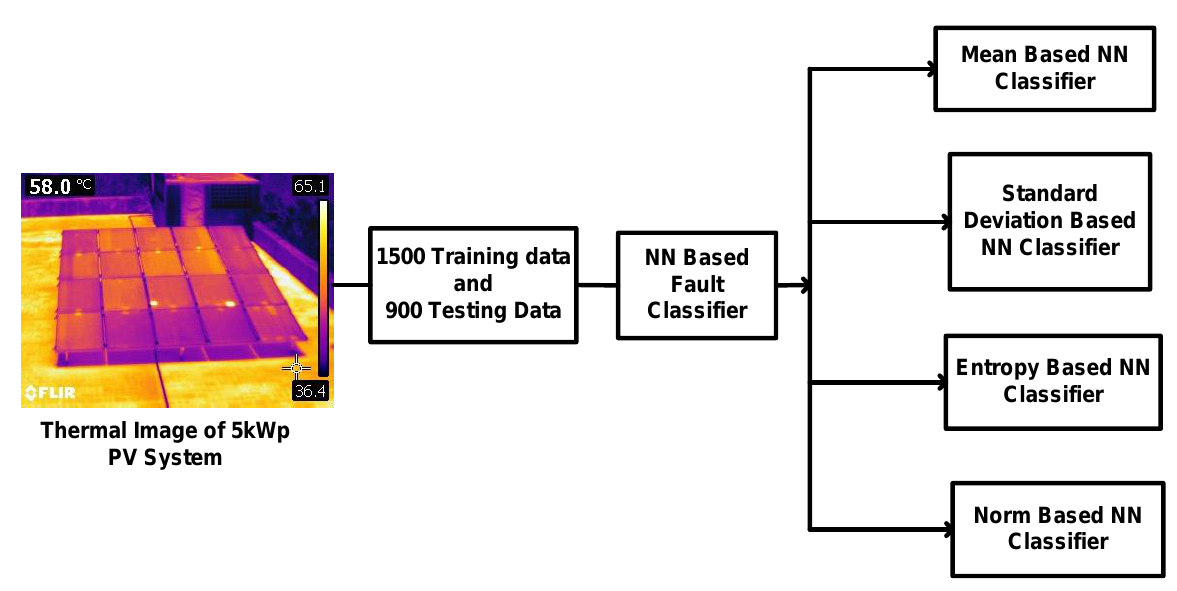
Figure 15. Window creation for each PV module.